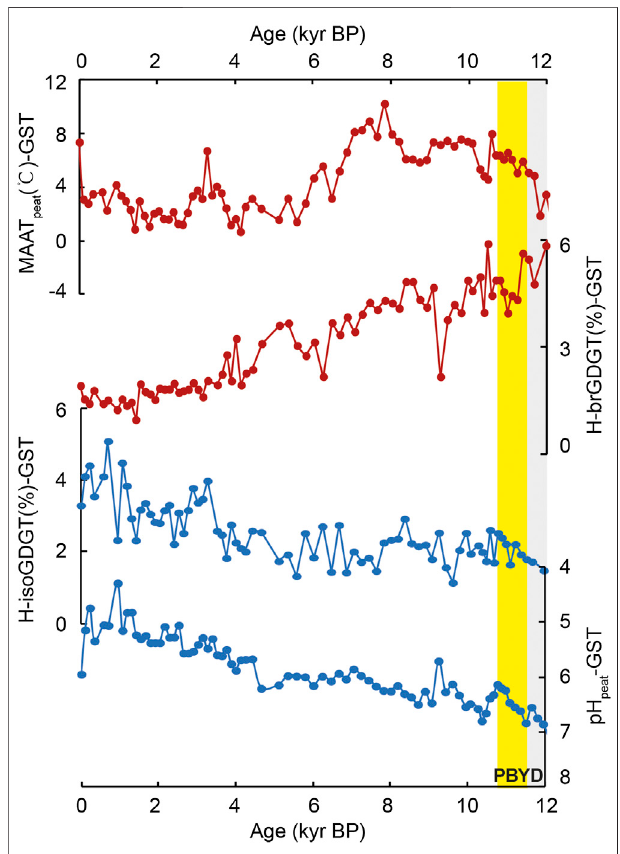
FIGURE 3 | Comparison of the abundance of H-isoGDGTs and H-brGDGTs ( Eqs 1 and 2 , respectively), mean annual air temperature (MAAT peat ) and pH peat in Gushantun peat. YD and PB are known as the Younger Dryas (YD) and the Preboreal, highlighted by the gray and yellow box, respectively (the depicted period is